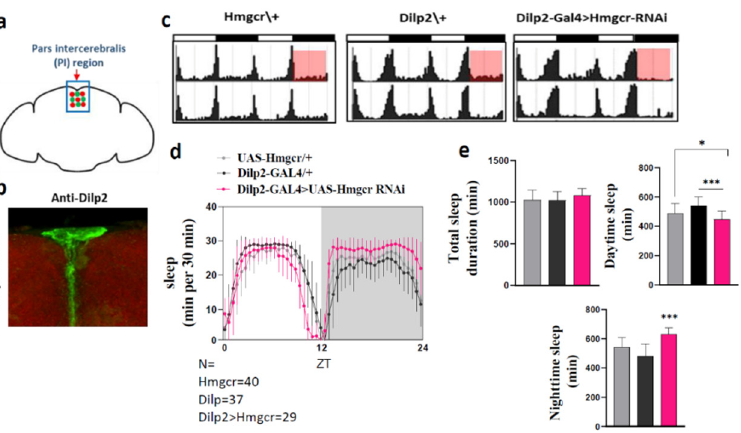
Figure 4. Sleep-activity patterns are affected by Hmgcr knockdown in Dilp2 neurons. ( a ) Diagram of different neuronal cells located in the PI region: these neurons complement each other. DH44 and the insulin ‐ producing cells, green and red circles, respectively. ( b ) PI neurons were stained by anti ‐ Dilp2; the scale bar represents 10 μ M. ( c – e ) Activity and sleep data for experimental and controls, male flies (n = 32) in L:D conditions. ( c ) White bars indicate daytime (ZT0–12); black bars indicate night (ZT 12–24). The genotypes are indicated above the panels. Red boxes denote the locomotor activity during the night. ( d ) Architecture of the sleep parameters. Light area indicates daytime (ZT0–12); gray area indicates night (ZT 12–24). The genotypes are indicated above the graph. ( e ) Graphs indicate locomotor activity, as well as the amount of day and night sleep in minutes. Gray bar = w 1118 > UAS ‐ Hmgcr RNAi control, Black bar = Dilp2 ‐ GAL4 > w 1118 control, Pink bar = Dilp2 ‐ GAL4 > UAS ‐ Hmgcr RNAi experimental. Results with error bars are mean ± S.D. To detect the signif ‐ icant difference between groups a Shapiro–Wilk test was performed to determine normality, then a One ‐ way ANOVA and Bonferroni post hoc test was performed to detect significance for total sleep, daytime sleep, and night sleep. * p < 0.01, *** p < 0.0001.